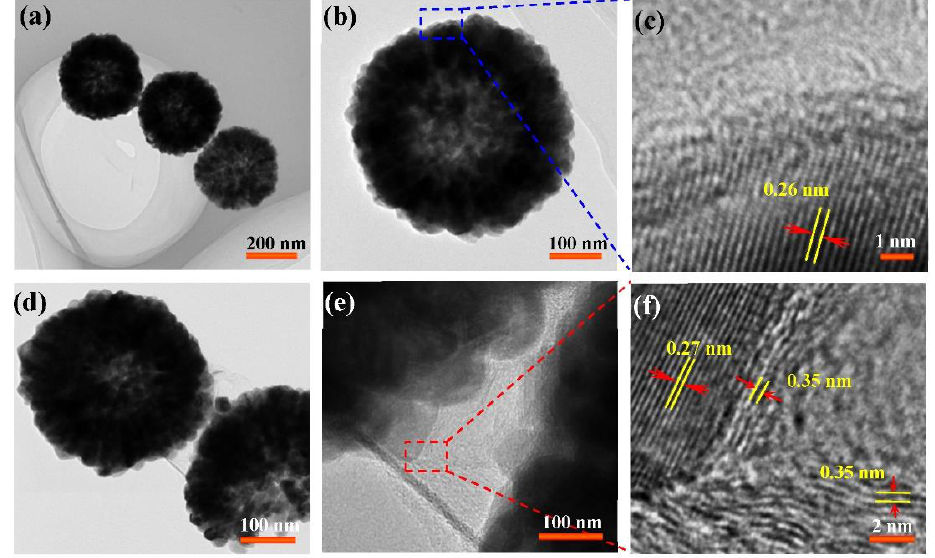
Figure 3. TEM images of two samples ( a – c ) SnO 2 and ( d – f ) r-SnO 2 /GN. To evaluate their potential application as supercapacitors, electrochemical properties Pore size distribution curve and N 2 adsorption–desorption isotherm of two samples of electrodes SnO 2 and r-SnO 2 /GN were tested. CV curves of two electrodes at a are shown in Figure 4. According to the experimental data, the specific surface area of sample SnO 2 is 43.58 m 2 g −1 and the average pore size is about 3.86 nm. By contrast, sam-